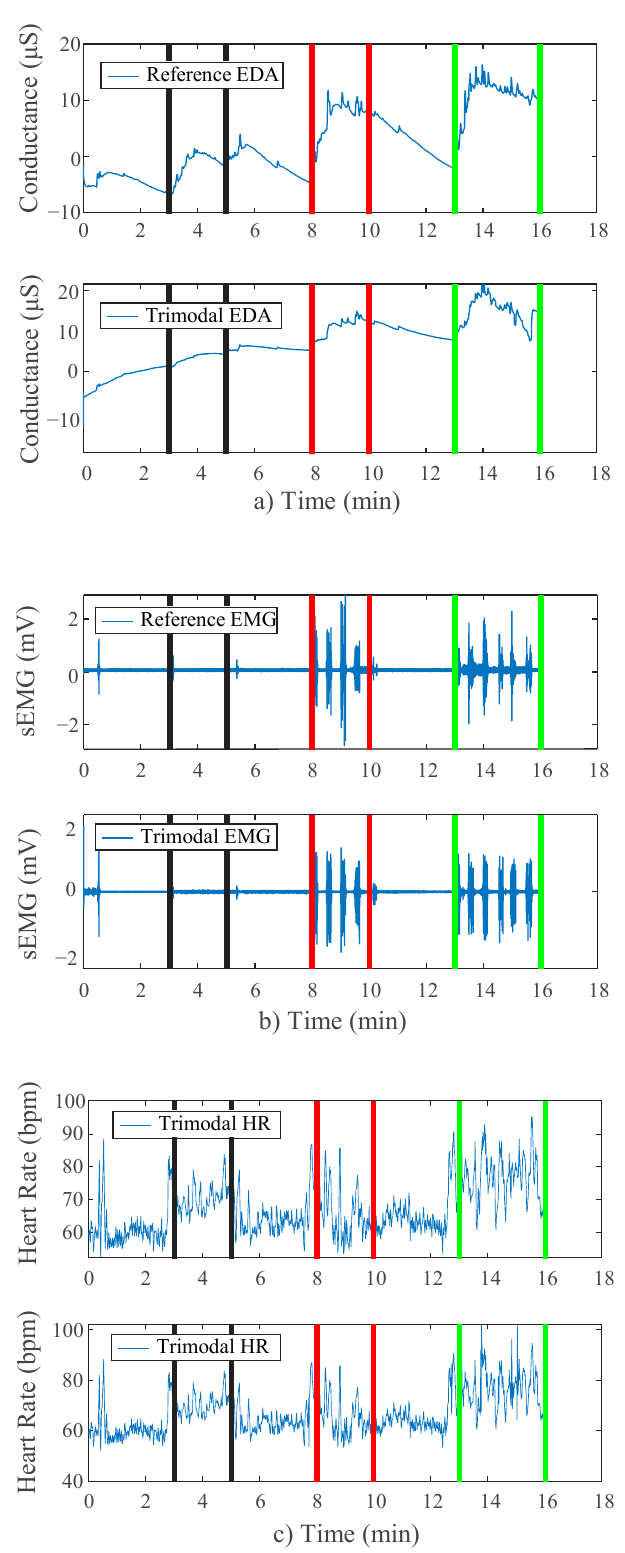
Figure 9. ( a ) EDA side by side comparison for modified protocol; ( b ) EMG side by side comparison for modified protocol; ( c ) HR side by side comparison for modified protocol testing battery power capability. Lines mark tests: black (Stroop), red (bicep), green (combo).